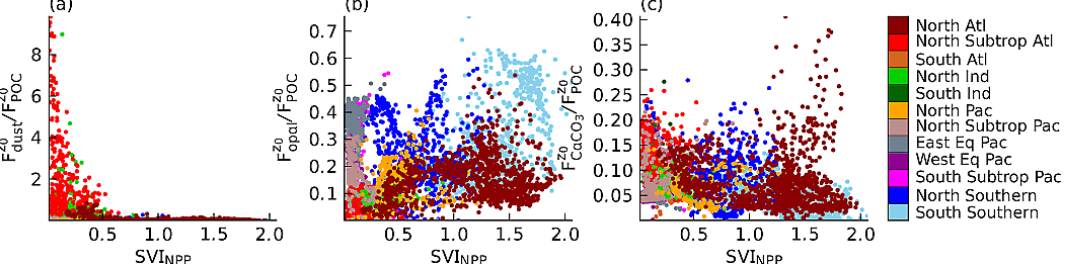
Fig. 10. Seasonal variation index for NPP ( SVI NPP ) plotted against the ratios of (a) dust, (b) opal and (c) CaCO 3 flux to POC flux at the export depth (z 0 ) from CCSM–BEC. SVI NPP is defined as the coefficient of variation ( SVI NPP = σ NPP from